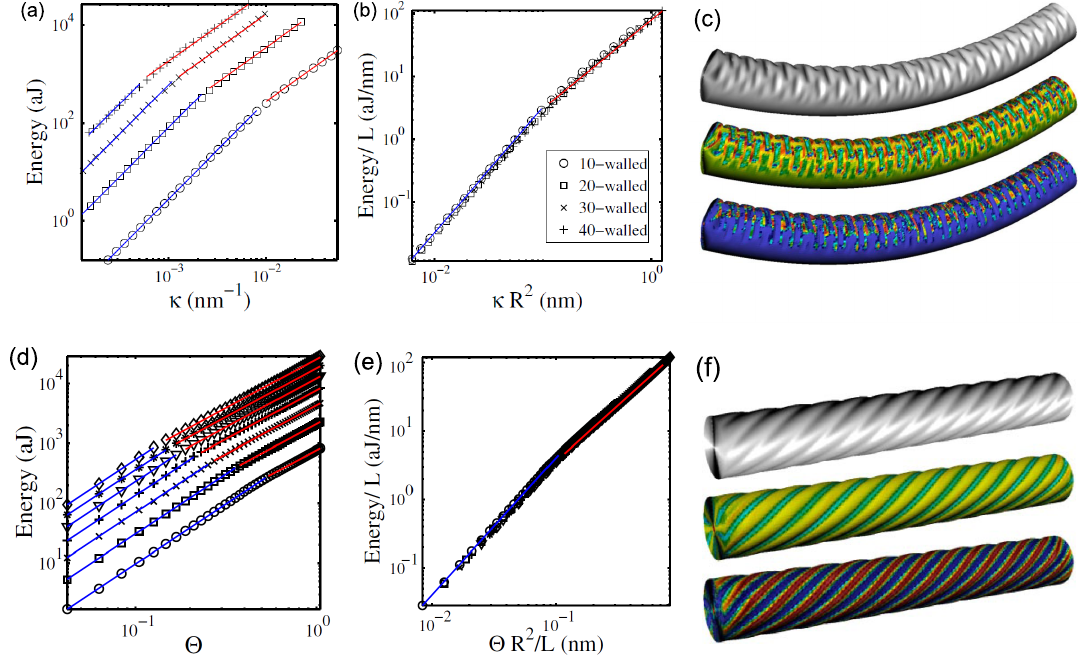
Figure 19. ( a,d ) Strain energy curves as a function of the bending curvature κ and the twisting angle (cid:2) ; ( b,e ) Data collapse upon appropriate rescaling. The power-law fits with exponents 2 (blue) and a ( < 2) (red) are shown for illustration. In all four plots, the number of walls increases stepwise from 10 (circles) to 40 (crosses); ( c ) 40-walled nanotube in pure bending; ( f ) 35-walled nanotube in torsion. The latter two panels present the deformed shape (top), Gaussian curvature map (middle, with green being zero, red being positive, and blue being negative), and energy density map (bottom, with red being high and blue being